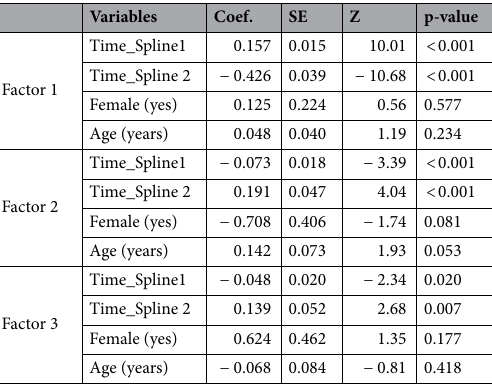
Variables Coef. SE